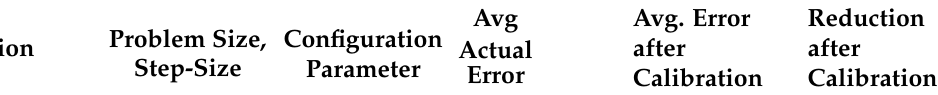
Table A2. Percentage error of dynamic energy consumption with RAPL and HCLWattsUp on HCLServer03. G = Threadgroups and T =